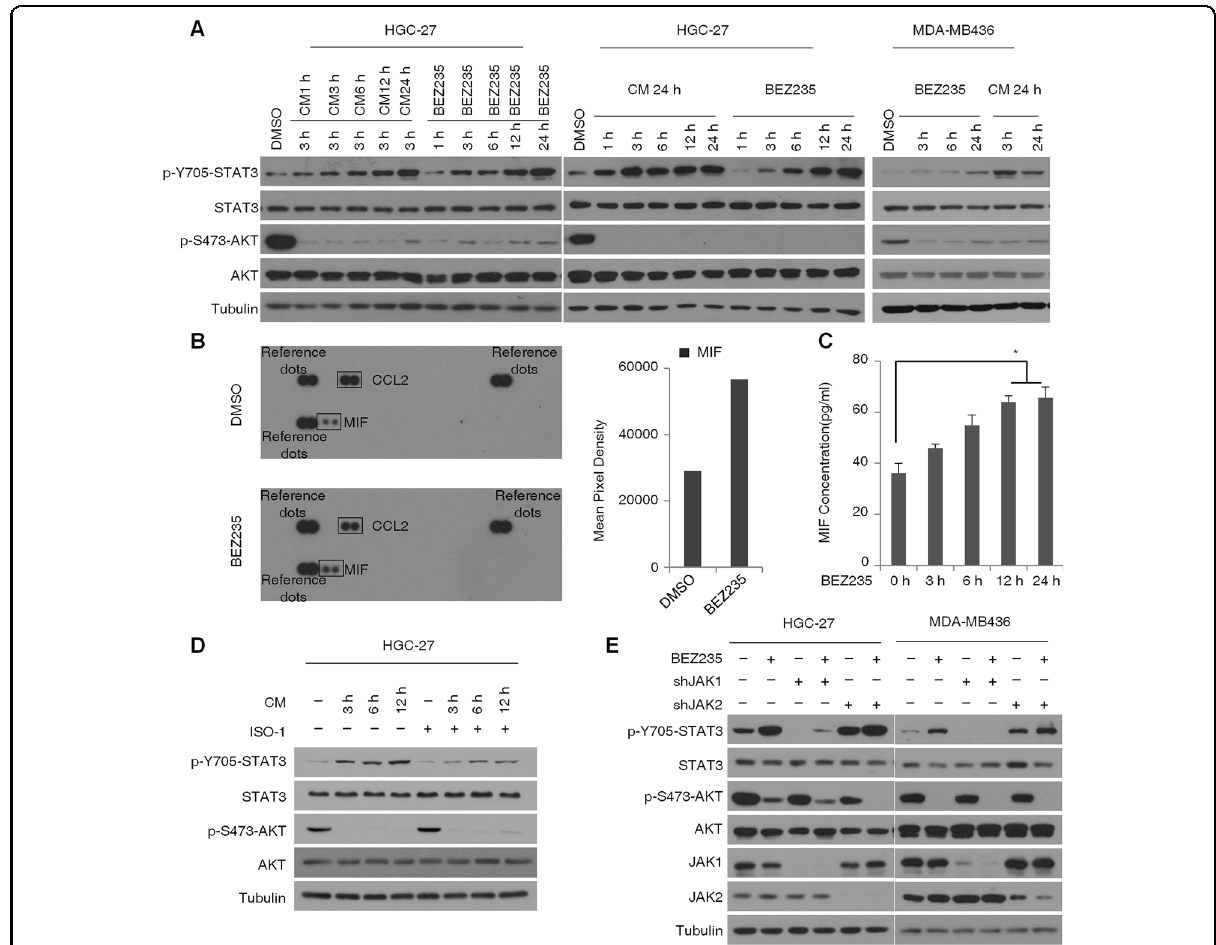
Fig. 4 PI3K/mTOR inhibitor BEZ235 activates STAT3 through MIF and JAK1. A Immunoblots showing expression levels of p-STAT3, T-STAT3, p- AKT, and T-AKT in HGC27 cells cultured for 3 h in CM of BEZ235-treated (100nM for indicated durations) cells (left panel), HGC27 cells (middle panel), and MDA-MB-436 cells (right panel) cultured for the indicated durations in 24 h CM of BEZ235-treated (100 nM) cells BEZ235-treated cells were used as controls. B Human cytokine array blot (left panel) showing the secreted cytokine pro fi le of control and BEZ235-treated (100nM for 24 h) HGC-27 cells. The bar graph shows fold change in secreted MIF levels. C Bar graphs showing the levels of MIF secretion in CM of HGC-27 cells treated with 100 nM BEZ235 for indicated durations. Levels of MIF secretion were measured by ELISA and are shown as means ± SD of triplicates. * P < 0.05. D Immunoblot showing expression levels of p-STAT3, T-STAT3, p-AKT, and T-AKT in HGC-27 cells pre-treated with ISO-1 (10 μ M) for 2 h, and cultured in BEZ235-treated (100 nM) CM alone or in combination with ISO-1(10 μ M) for indicated durations. E Immunoblot showing expression levels of p- STAT3, T-STAT3, p-AKT, and T-AKT in the control, JAK1 and JAK2-knockdown HGC-27 and MAD-MB436 cells treated with BEZ235 (100 nM) for 24